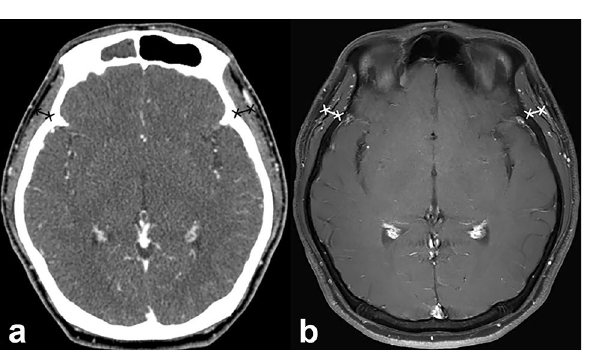
Figure 2. Representative case for the assessment of temporalis muscle thickness (TMT) on CT and MRI. A 41-year-old patient has an averaged TMT of 6.66 mm on CT ( a ) and 8.04 mm on MRI ( b